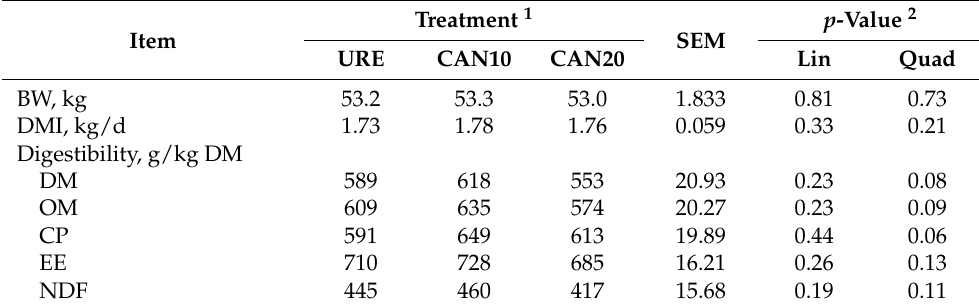
Table 2. Effects of calcium-ammonium nitrate (CAN) fed to lactating dairy goats on body weight, dry matter intake, and apparent digestibility of nutrients.